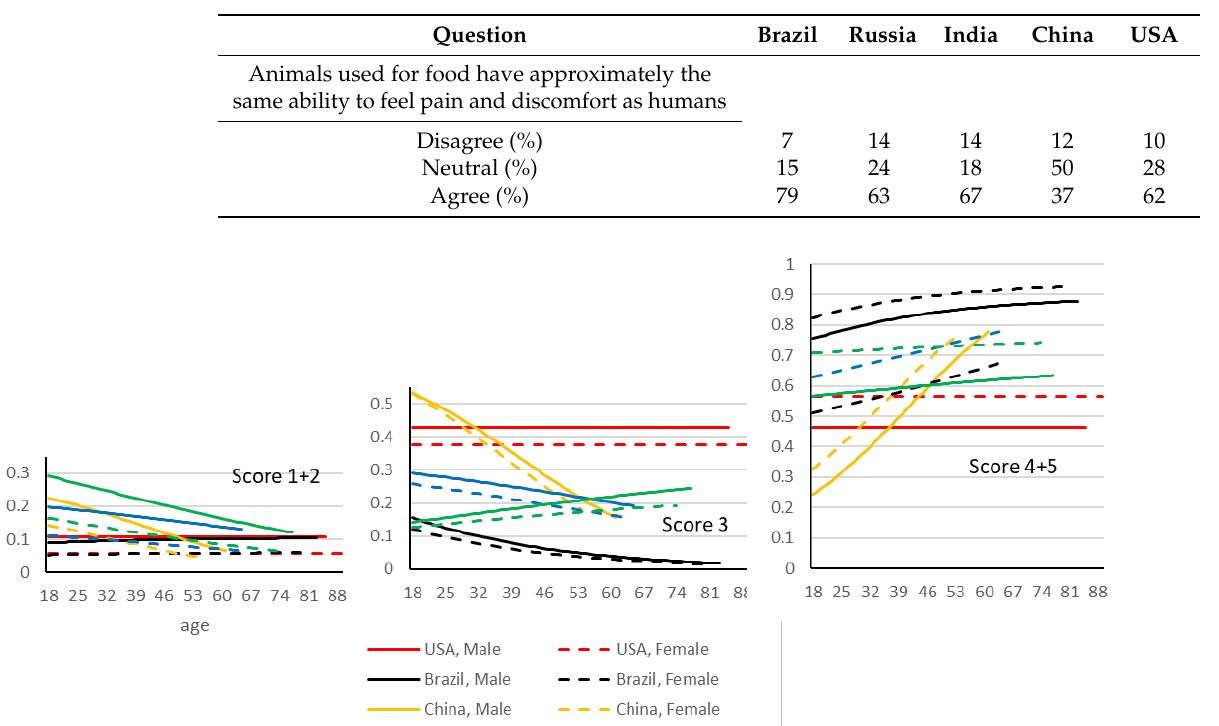
Figure 3. Sampled variables distribution. Ages within gender and countries. Table 1. Percentage of respondents to the question in each of the countries in each of the categories disagree, neutral and agree.